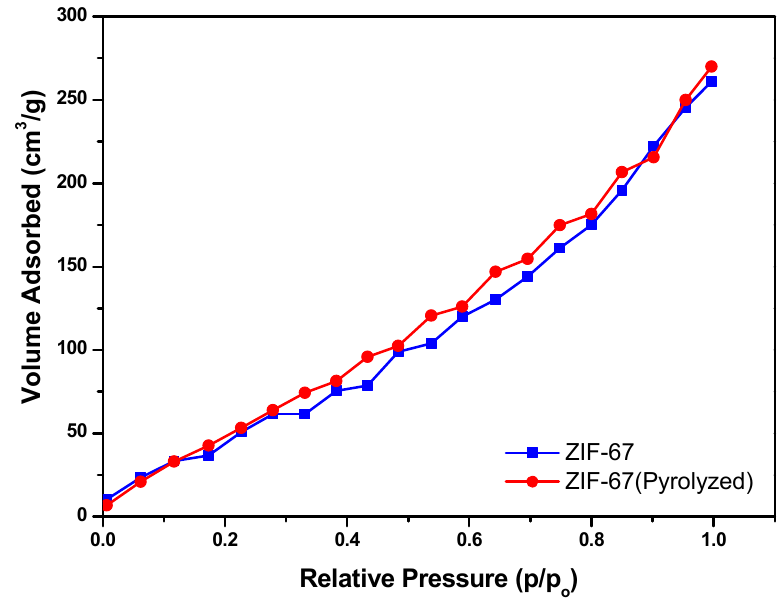
Figure 6. Surface area analysis by BET characterization of ZIF-67 and Pyrolyzed ZIF-67.